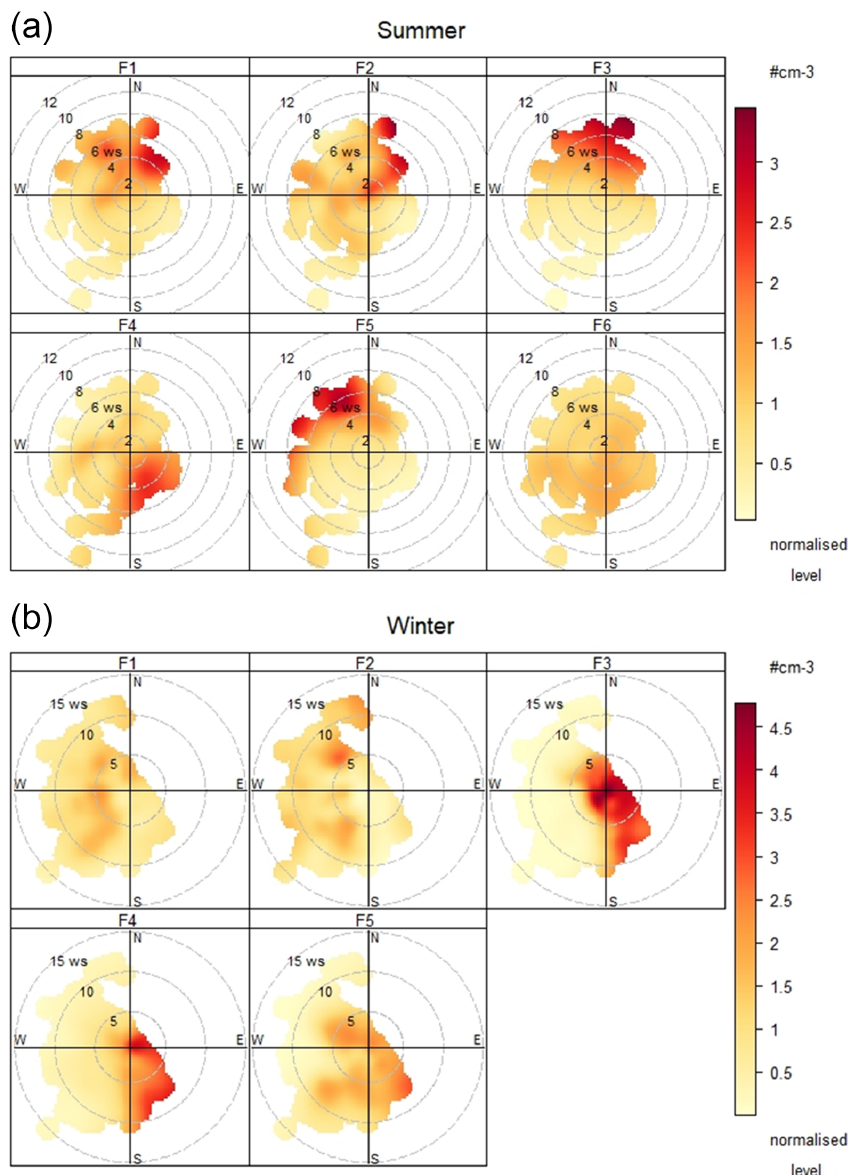
Figure A13. Polar plot with factors concentrations (1h vector-averaged WS and WD) for summer (a) and winter (b) .